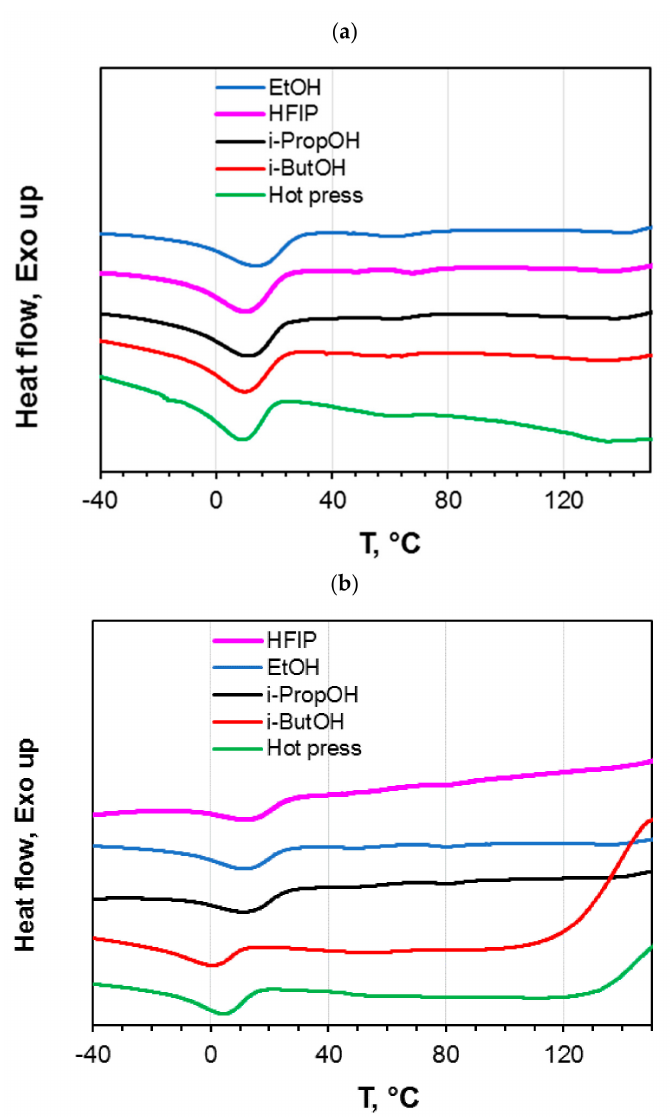
Figure 5. Differential scanning calorimetry (DSC) thermograms (shifted vertically for clarity) relative to the first heating of Pebax ® 2533 films. ( a ) ‘as prepared’ films (T0 samples); ( b ) photo-oxidated samples (6 h). Table 5. Thermal data of the poly (tetramethylene oxide) (PTMO) melting peak from DSC curves